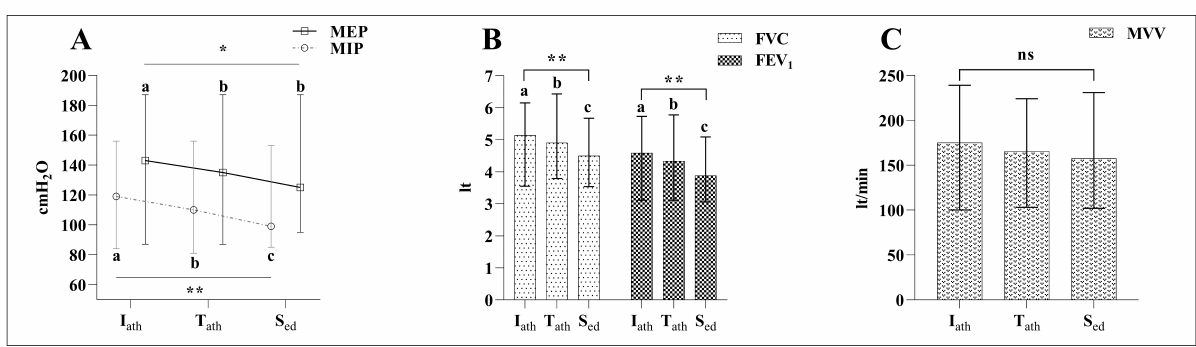
Fig. 2. Respiratory muscle strength and pulmonary functions between groups [I ath ( n =97) ; T ath ( n =134) ; S ed ( n =40) ]. All data were expressed as median (min–max). (A) Respiratory muscle strength. (B,C) Pulmonary functions (n = 271). a,b,c No significant differences between groups that share the same letter. ** p < 0.001; * p < 0.05; ns, non-significant; I ath , Individual athletes; T ath , Team athletes; S ed , Sedentary; MIP, Maximal inspiratory pressure; MEP, Maximal expiratory pressure; FVC, Forced vital capacity; FEV 1 , Forced vital capacity at 1 second; MVV, Maximal voluntary